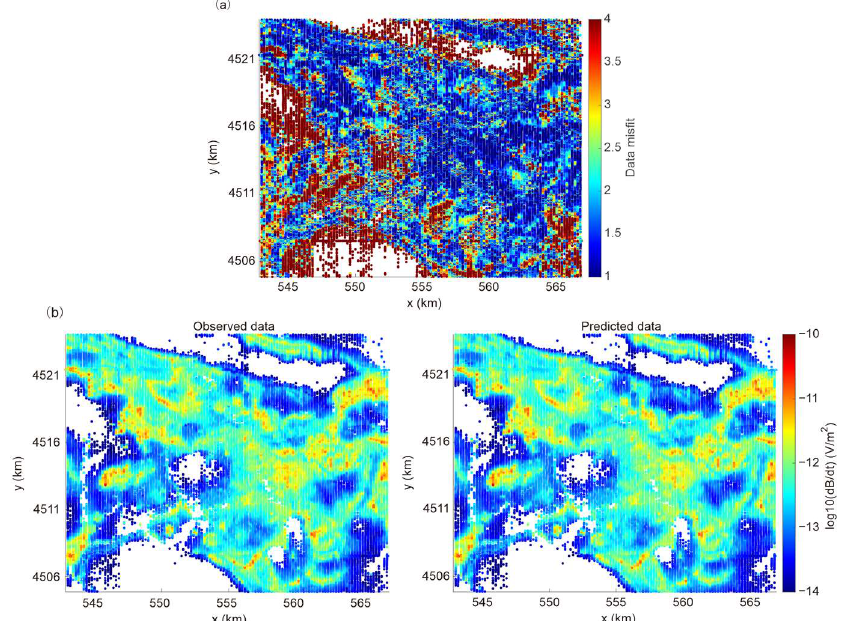
Figure 5. Data misfit and comparison between the observed data and predicted data. ( a ) Data misfit. ( b ) A comparison between the observed data and predicted data at a time of 0.25 ms. The blank areas in the figures indicate the locations of the data that were removed during the preprocessing